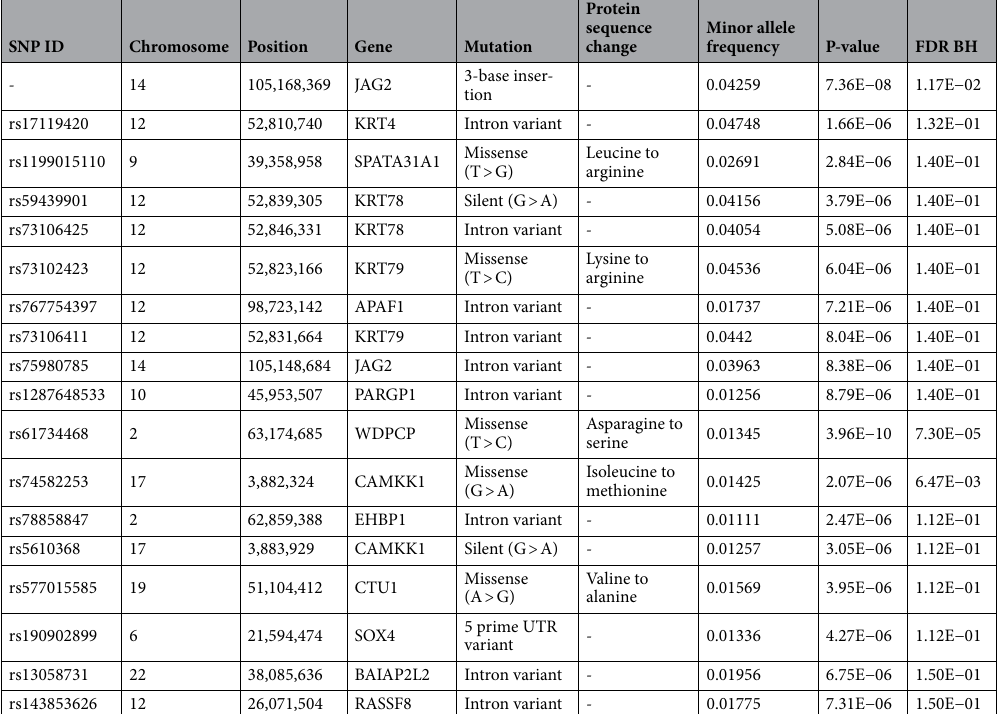
Table 1. Identified SNPs in male (rows 1-10) and female (rows 11-18)